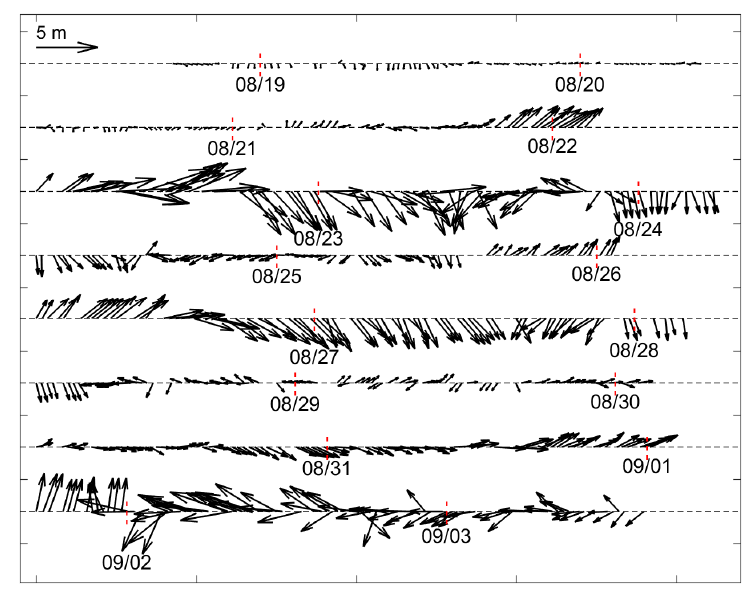
Figure 5. Vector direction indicating the mean wave direction during the observed period (numbers depicts the observation date). The length of the vector depicts the significant wave height. The northward direction is toward the top of the page.